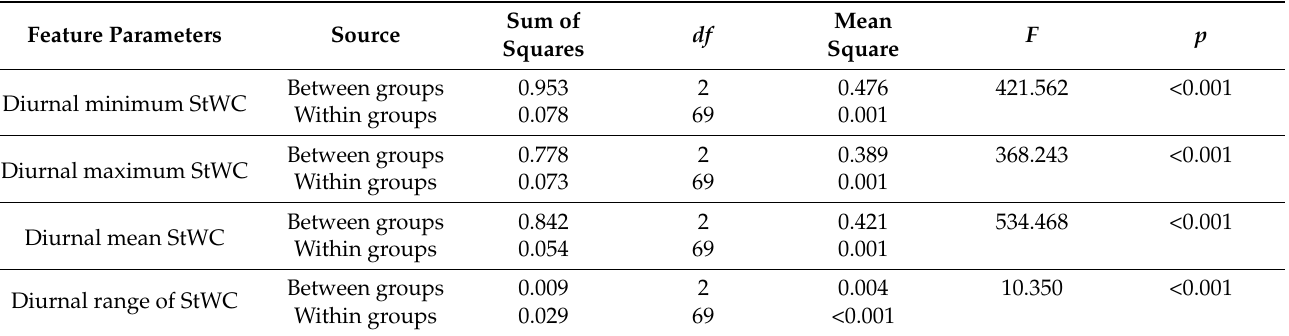
Figure 5. The means and standard deviations of four feature parameters of StWC measured on June 1 among different groups of Lagerstroemia indica L. Table 5. One-way analysis of variance to examine the effects of disease on four feature parameters of StWC in Lagerstroemia indica L.